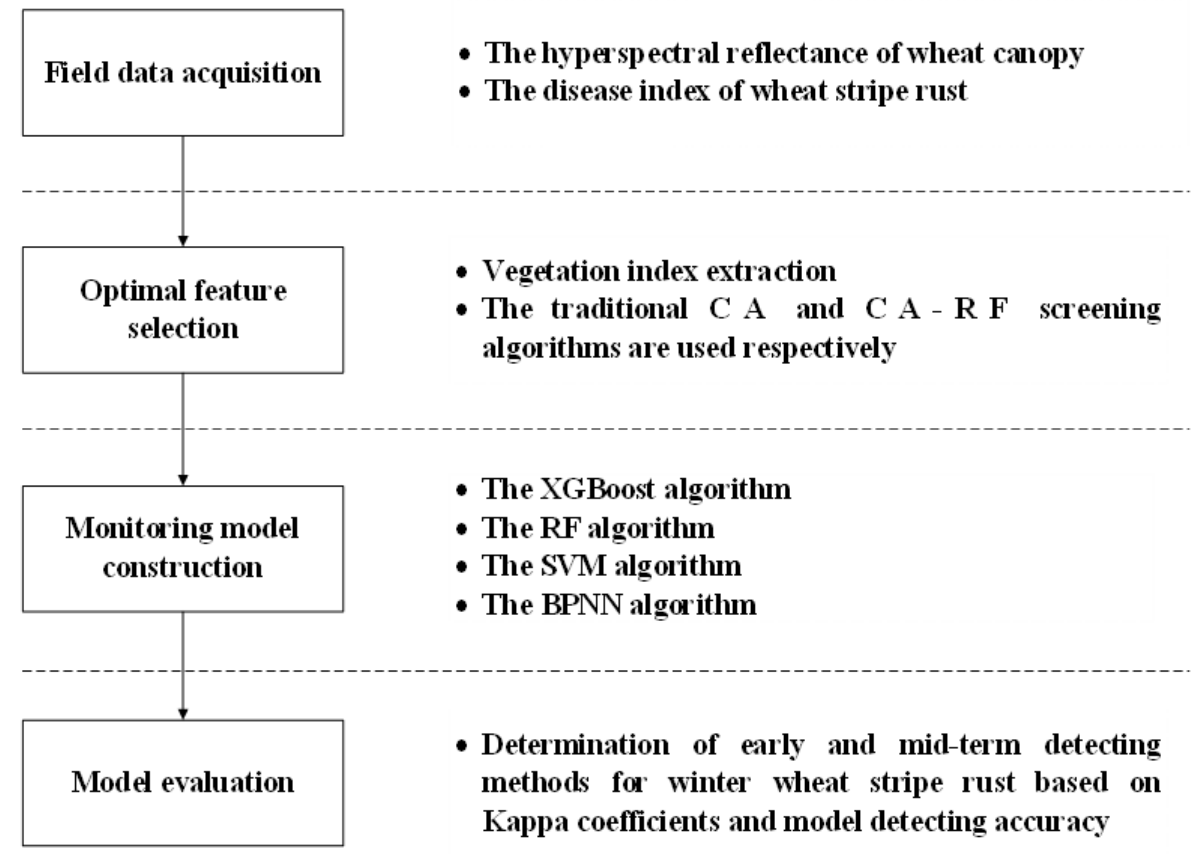
Figure 1. The workflow of the study. Note: CA indicates correlation analysis; CA-RF indicates correlation analysis combined with random forest algorithm; XGBoost indicates extreme gradient boosting method; RF indicates random forest method; SVM indicates support vector machine method; BPNN indicates backpropagation neural network method .